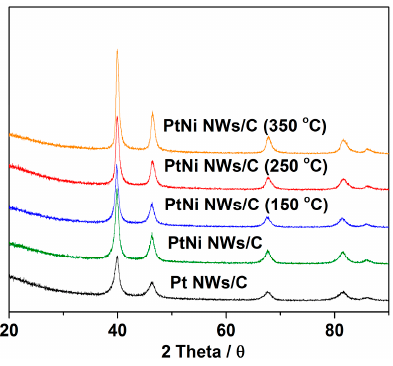
Figure 2. XRD patterns of Pt NWs/C and PtNi NWs/C.